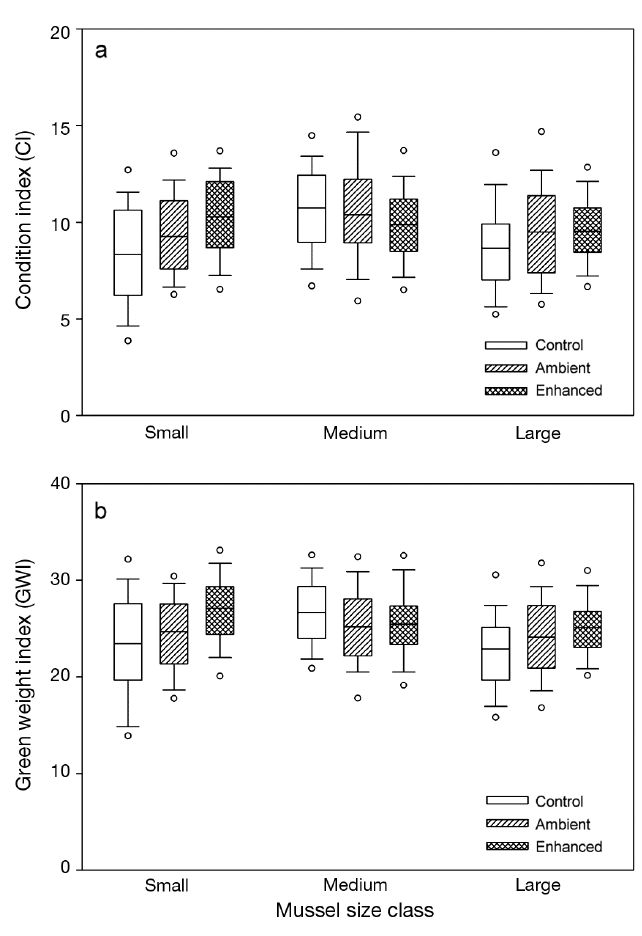
Fig. 7. Perna canaliculus . Individual mussel (a) condition in- dex (CI) and (b) green weight index (GWI) for the 3 size classes (small: 20−40 mm shell length at deployment, medium: 40−60 mm, and large: 60−70 mm) and fouling treatments (controls, ambient fouling, and enhanced Didem- num vexillum fouling). Crossbar inside each box indicates median; lower and upper box limits represent the 25th and 75th percentiles, respectively; bottom and top whiskers represent 10th and 90th percentiles, respectively; while lower and upper circles represent 5th and 95th percentiles,